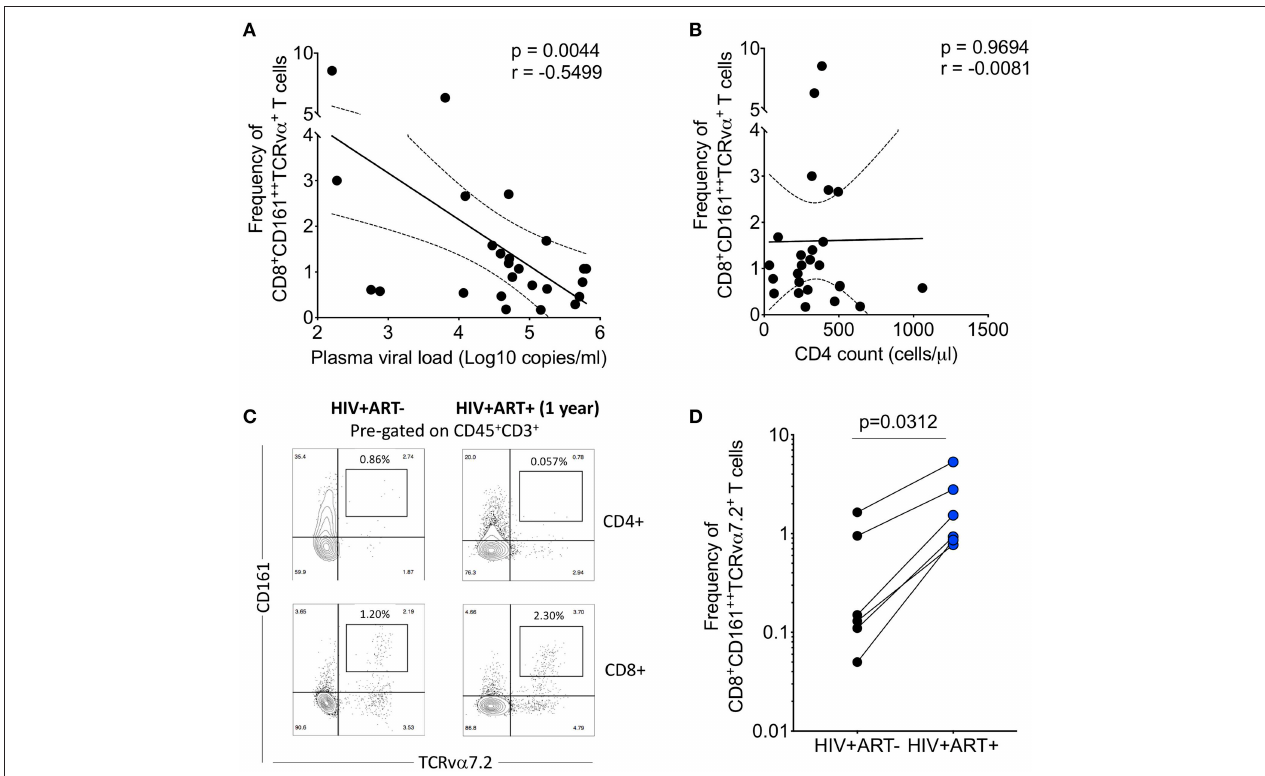
FIGURE 5 | Depletion of airway CD8 + CD161 ++ TCRv α 7.2 + T cells is inversely correlated with HIV plasma viral load. (A) Association between plasma viral load and frequency of airway CD8 + CD161 ++ TCRv α 7.2 + T cells. Plasma viral load was log transformed ( n = 25). (B) Association between peripheral blood CD4 count and frequency of airway CD8 + CD161 ++ TCRv α 7.2 + T cells ( n = 25). (C) Representative flow cytometry plots from an HIV-infected adult before and 1 year post ART initiation. (D) Frequency of airway CD8 + CD161 ++ TCRv α 7.2 + T cells in from HIV-uninfected adults (before and 1 year post ART initiation) compared to healthy controls (HIV + ART − / + , n = 6). Data was analyzed using Pearson correlation test (A,B) . Data were analyzed using Wilcoxon matched-pairs signed rank test for paired comparisons (D) . ART, anti-retroviral